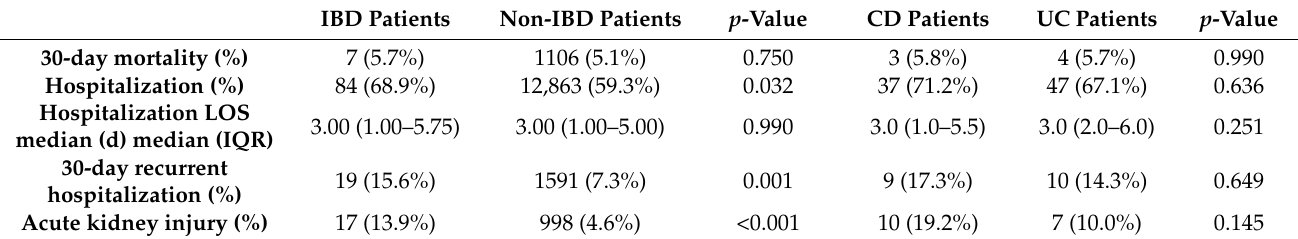
Table 3. Urinary tract infection outcomes.